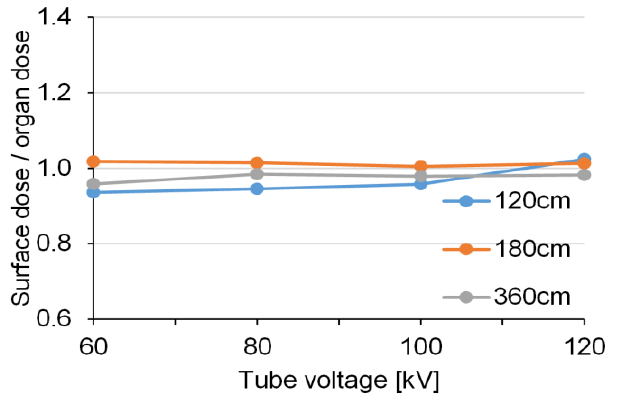
Figure 5. The effective dose calculated by the PC-based Monte Carlo program for calculating patient doses in medical X-ray examinations (with a grid). (AP: anteroposterior, PA: posteroanterior). Diagnostics 2020 , 10 , x FOR PEER REVIEW